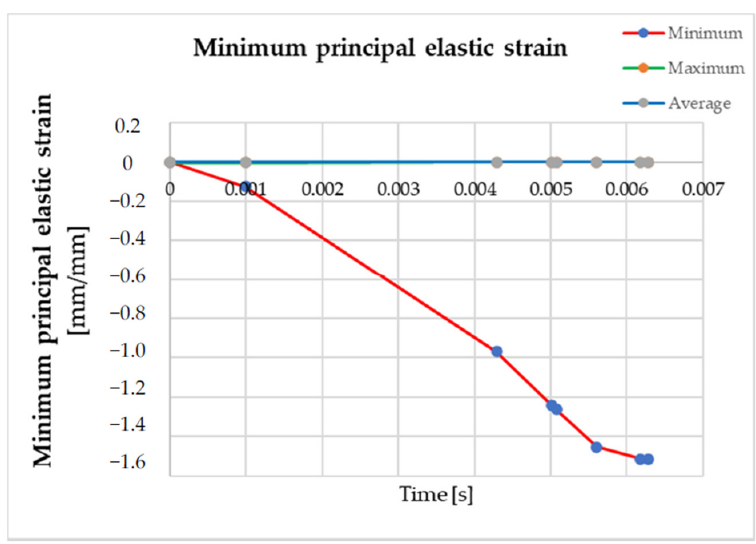
Figure 14. Diagram of minimum principal elastic strain.